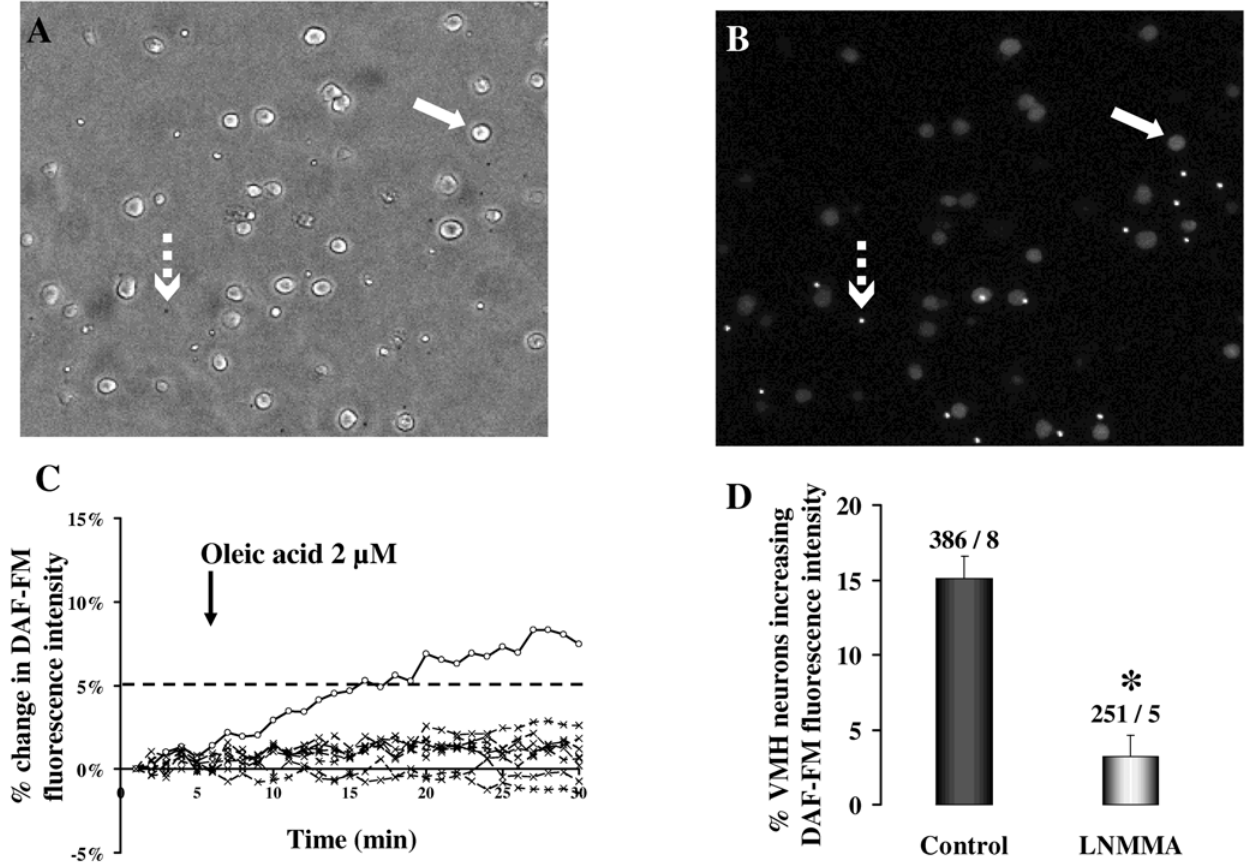
Figure 1. NO production by VMH neurons in response to oleic acid. A and B: Bright field (A) and DAF-FM fluorescence intensity images of cultured (24 H) VMH neurons from rats. Cells (solid arrow) are plated with fluorescent beads (broken arrow) which are used to calibrate changes in cell fluorescence intensity. C: Example of VMH neurons which increase (solid line, 1 neuron) or do not change (dashed line, 8 neurons) their DAF-FM fluorescence intensity in response to oleic acid (2 m M). Neurons increasing their DAF-FM fluorescence intensity above 5% after 15–25 min post oleic acid addition are considered to produce NO in response to oleic acid. D: Percentage of VMH neurons that increased their DAF-FM fluorescence intensity [NO production] in response to oleic acid (2 m M) in the presence or absence (Control) of the non-selective NOS inhibitor N-Methyl-L-arginine (L-NMMA, 1 mM). Data are presented as mean 6 sem. *: p , 0.05. Total number of cells – number of dishes used are given on the top of each bar.